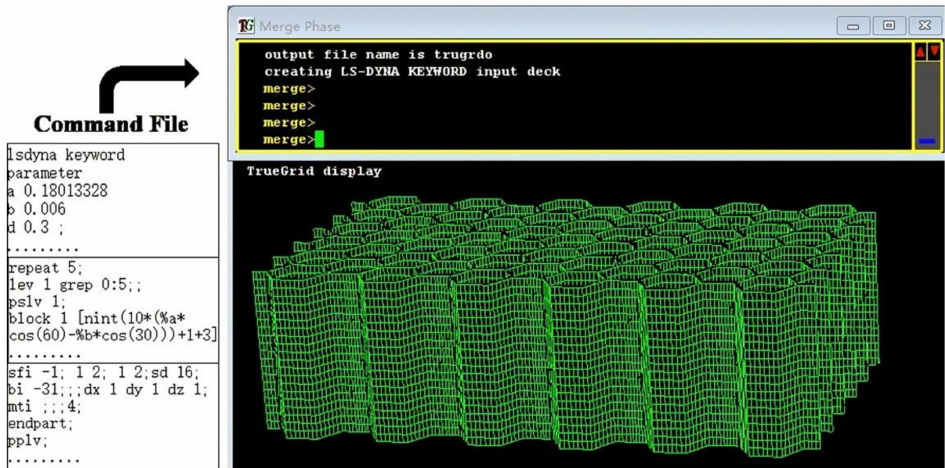
Figure 3. Modeling schematic diagram of honeycomb core.